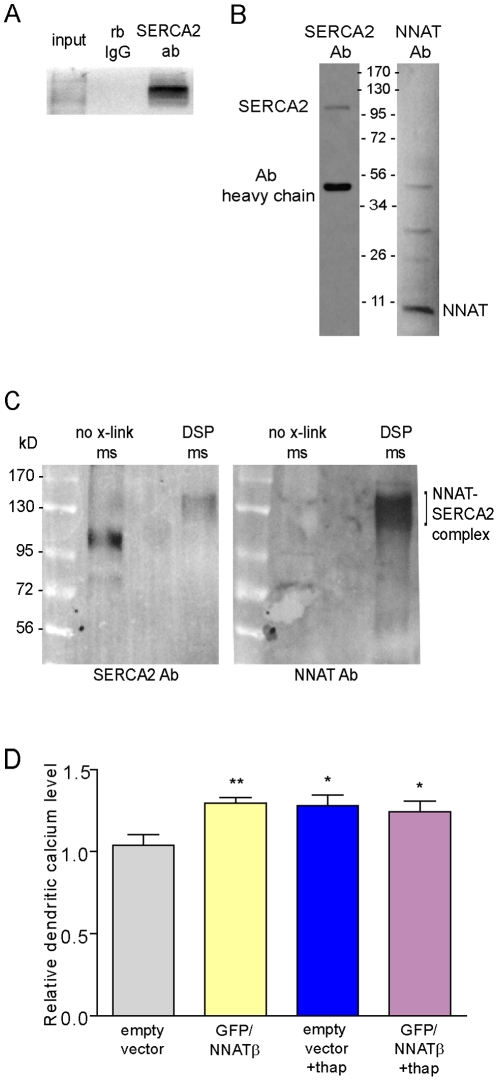
Neuronatin is associated with SERCA2 in the hippocampus.(A) SERCA2 antibody immunoprecipitation efficiency compared to rabbit IgG. 2.5% of input or immunoprecipitated samples were loaded. (B) NNAT was co-immunoprecipitated from microsomes using SERCA2 antibody. Pulldown was confirmed by immunoblotting with SERCA2 or NNAT antibody. (C) Microsomes were crosslinked with dithiobis [succinimidyl propionate] (DSP) followed by SERCA2 immunoprecipitation and immunoblot analysis. SERCA2 antibody (left) recognizes a 114 kD band in uncrosslinked microsomes and a size-shifted complex at 120–150 kD after crosslinking and IP. Right, membrane was stripped and reprobed with NNAT antibody, revealing the presence of NNAT within the 120–150 kD complex. (D) Overexpression of GFP/NNATβ occludes Ca2+ elevation by thapsigargin (GFP/NNATβ+thap), as measured using Calcium Crimson-AM, suggesting that NNAT antagonizes SERCA pump activity (empty vector: n = 24 dendrites, 14 neurons; GFP/NNATâ: n = 33 dendrites, 14 neurons; empty vector+thap: 18 dendrites, 8 neurons; GFP/NNATβ+thap: 19 dendrites, 8 neurons; GFP/NNATβ+thap+Glu: 19 dendrites, 9 neurons. **p<0.01, *p<0.05). Experiments were performed using at least 2 independent batches of cultures.